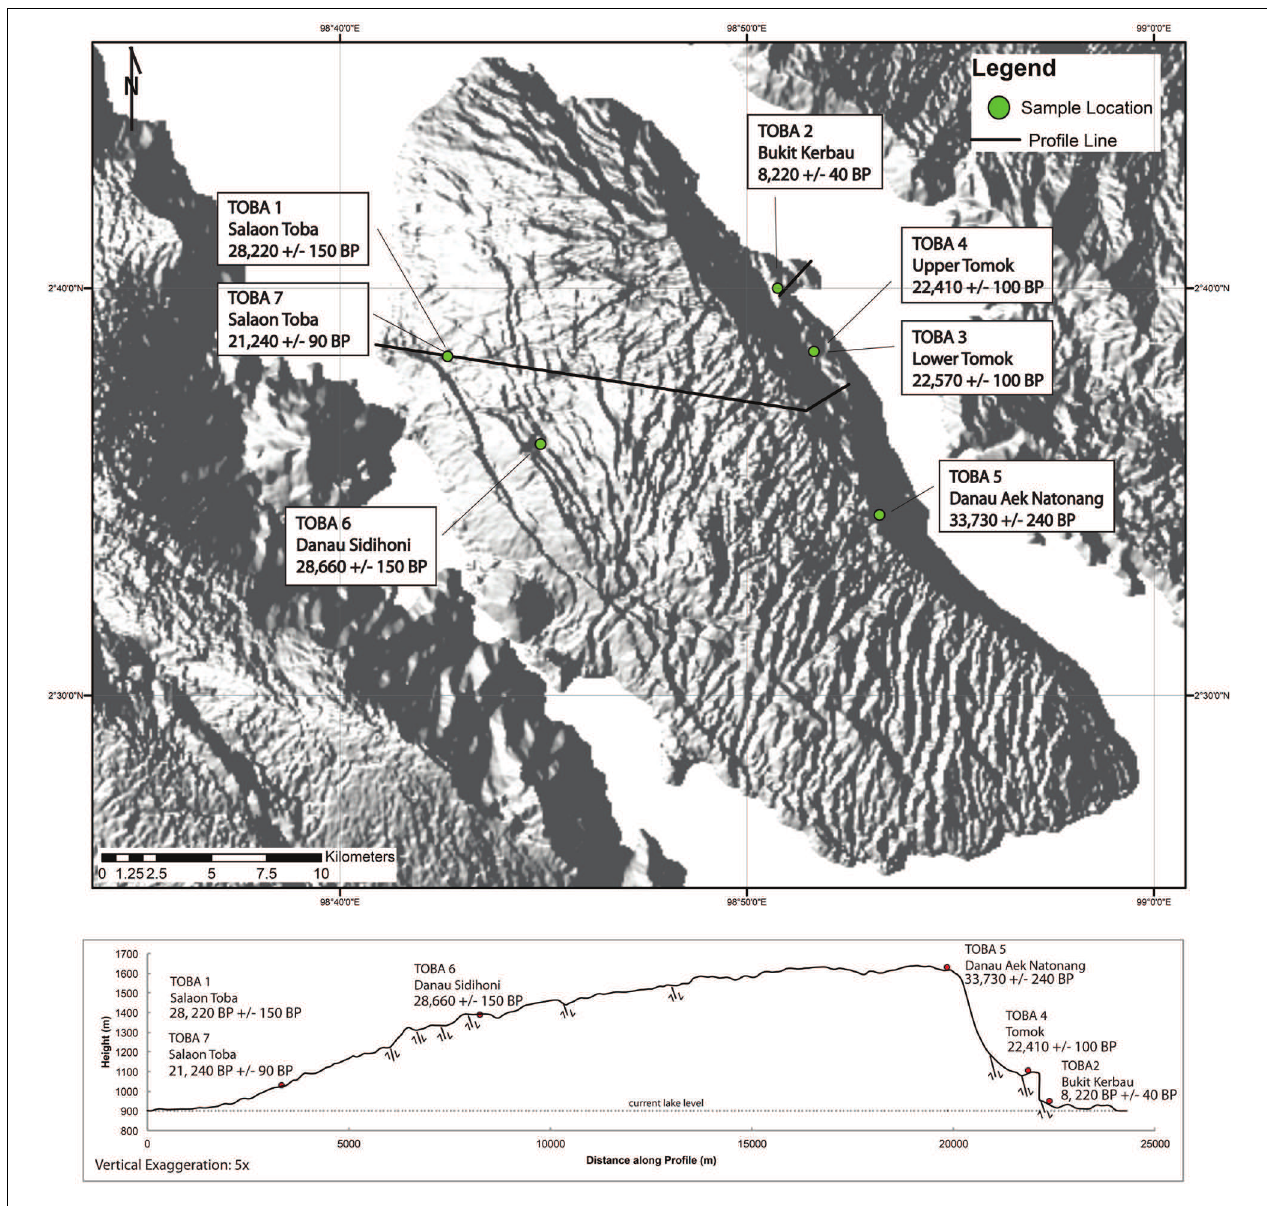
elevations. The sample locations are projected on to the line of profile shown below. Location and sense of motion of the major faults that intersect the line of section are also